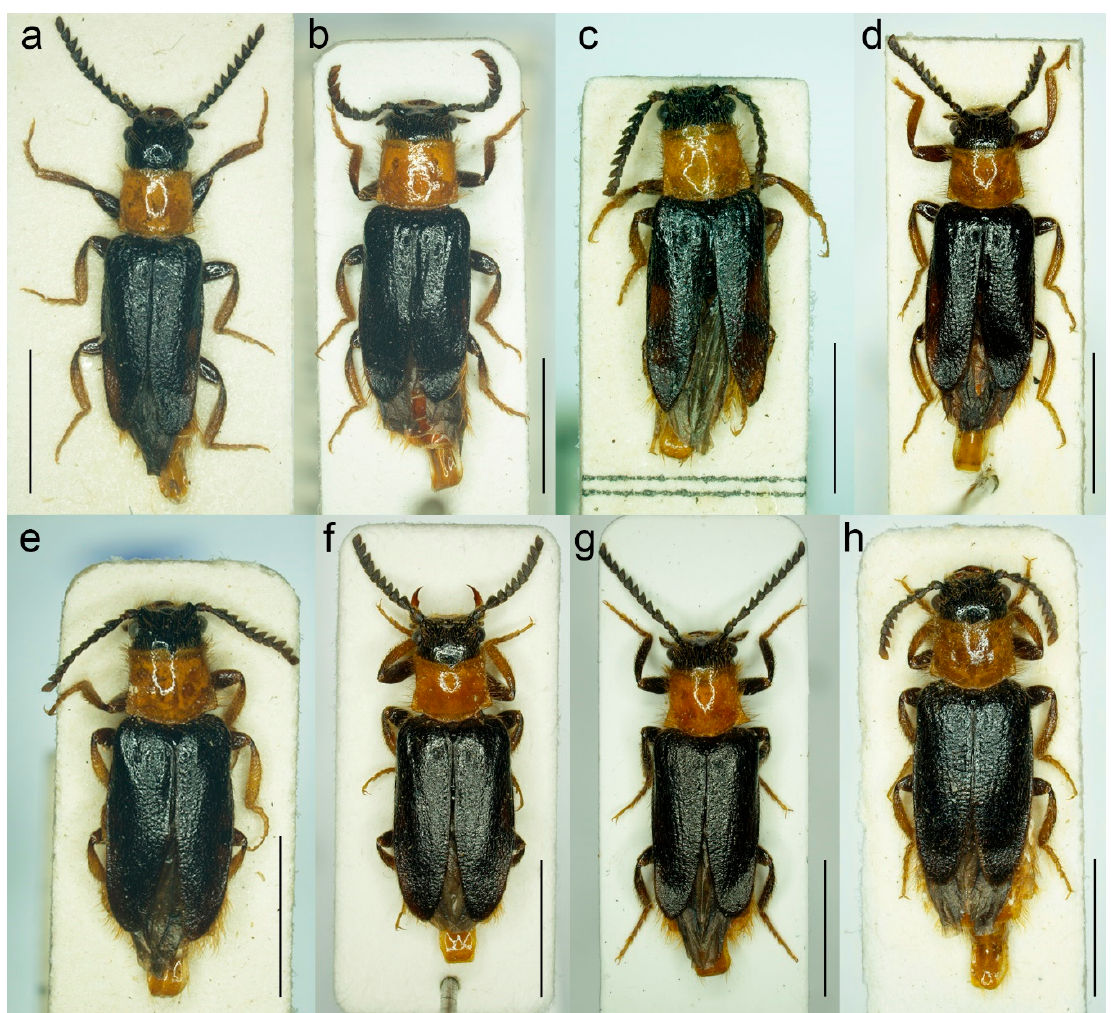
Figure 18. Malacogaster passerinii Bassi, 1834, male, habitus, dorsal view. ( a ) Specimen from Sardinia (MZLU); ( b ) specimen from Sardinia (HNHM); ( c ) specimen from Sicily (NMPC); ( d ) specimen from Sardinia (PCRK); ( e ) specimen from Tunisia (NMPC); ( f ) specimen from Tunisia (NMPC); ( g ) specimen from Tunisia (PCRK); ( h ) specimen from Spain (NMPC). Scale bars = ( a ) 2.5 mm; ( b , d , e , h ) 3.5 mm; ( c ) 3.0 mm; ( f , g ) 4.0 mm.